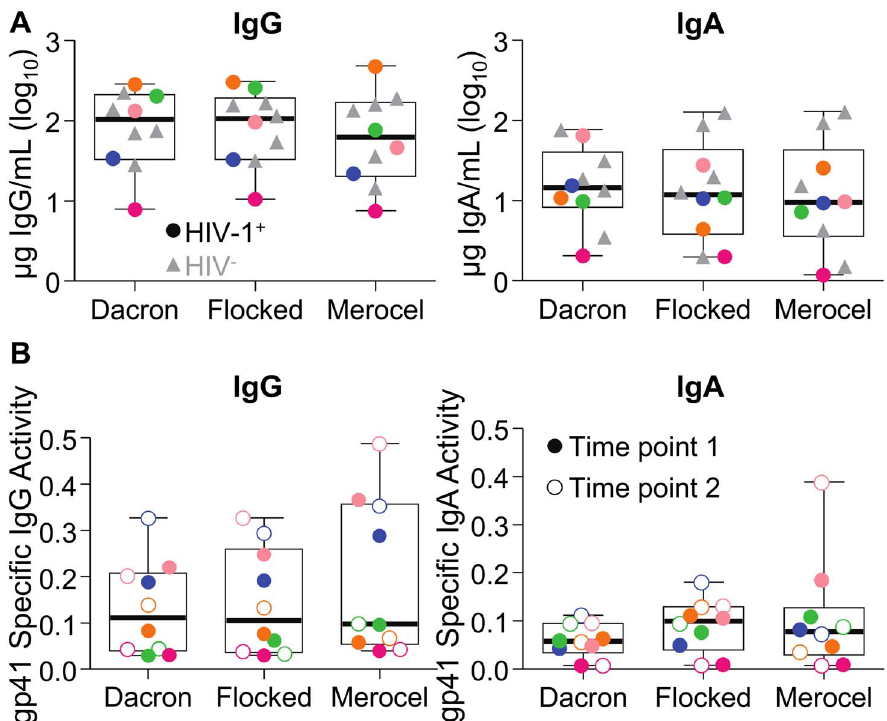
Figure 1. Total and HIV-1-specific IgG and IgA in vaginal secretions do not differ by sampling device or timepoint in the same women. (A) Dacron swabs, flocked swabs, and Merocel sponges were collected from 5 HIV-1 infected (colored circles) and 5 HIV uninfected (grey triangles) women and the eluate was analyzed for total IgG (left) and total IgA (right). Symbols represent the average of two collection time points spaced one hour apart, for each woman and sampling device. For HIV-1 infected women, colors indicate specific individuals. (B) Samples from the first time point (filled circles) and one hour later (open circles) from the 5 HIV-1 infected women were analyzed for gp41-specific IgG (left) and IgA (right) activity, calculated as antigen-specific mean fluorescence intensity (MFI)/ng ml 2 1 total IgG or IgA. Colors indicate specific individuals. The box-and- whisker plots represent median, 25 th and 75 th percentiles, and range.